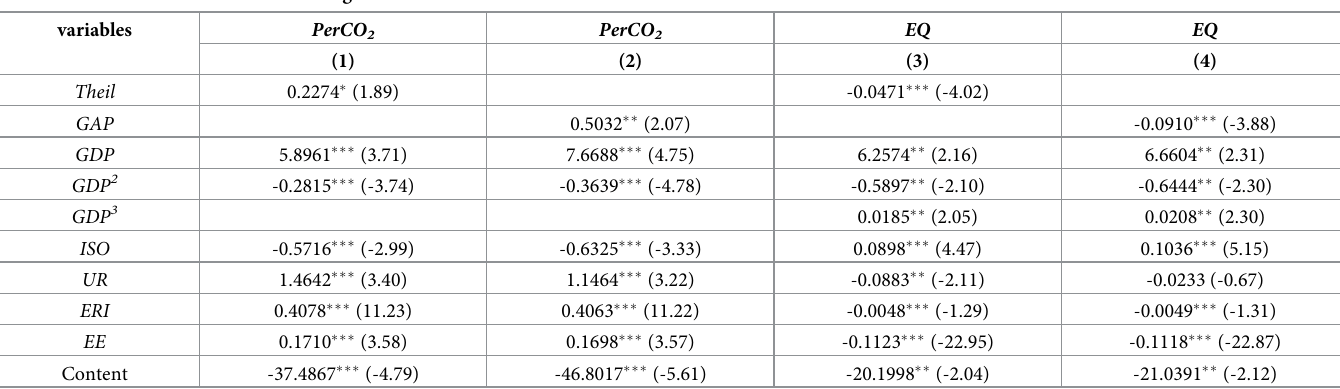
Table 5. Instrumental variable method regression results.